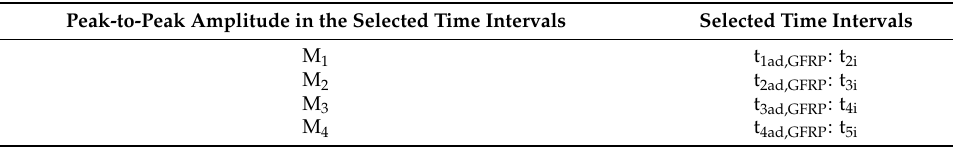
Table 5. Selected time intervals with significant change in amplitude.